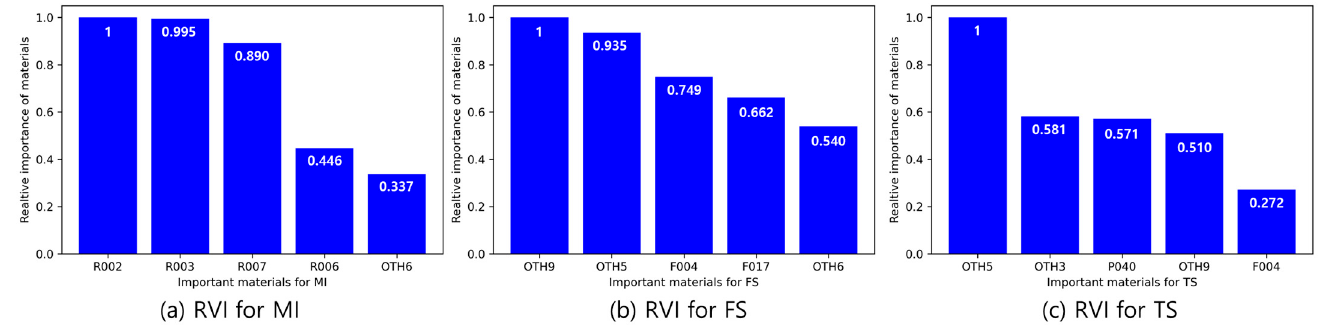
Figure 15. RVIs of ( a ) MI, ( b ) FS, and ( c ) TS for three physical properties.